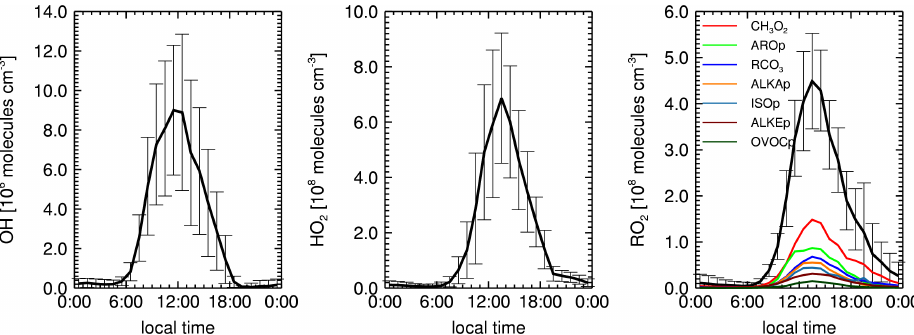
Fig. 1. Average diurnal profiles of OH, HO 2 and RO 2 (black lines) in the standard model (S0). The vertical bars show the hourly standard deviations. The color lines in the rightmost panel show the major components of RO 2 , which are described in the text.